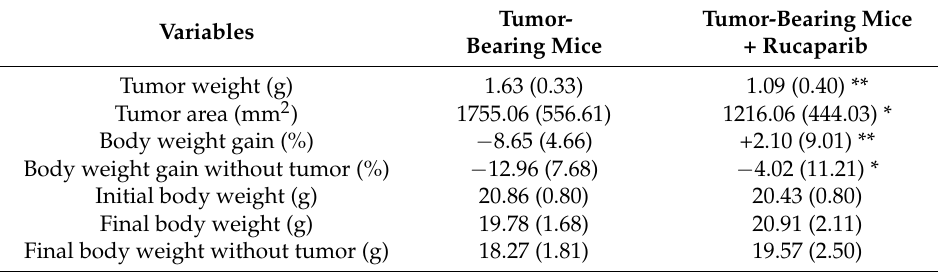
Table 1. Physiological and tumor characteristics in the study groups of mice.